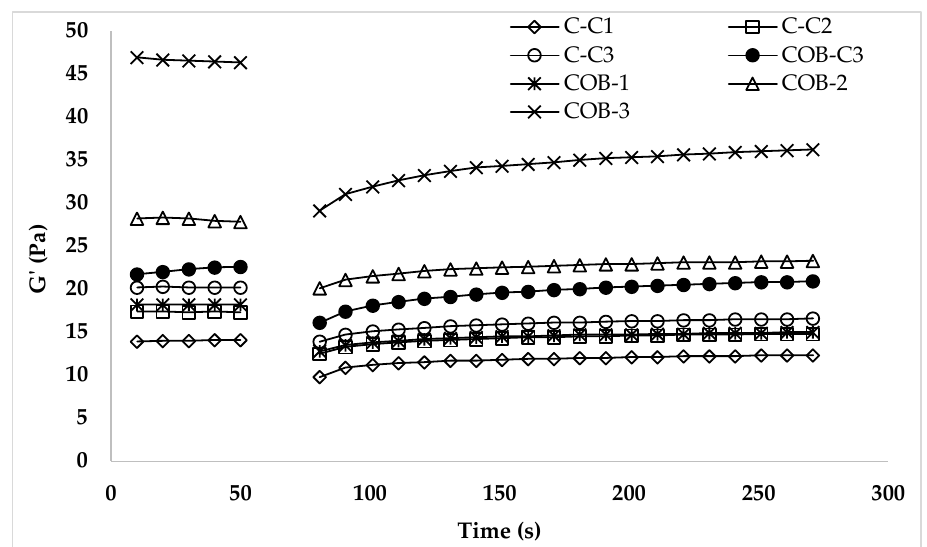
Figure 4. The 3-ITT rheological properties of ice cream mixes.